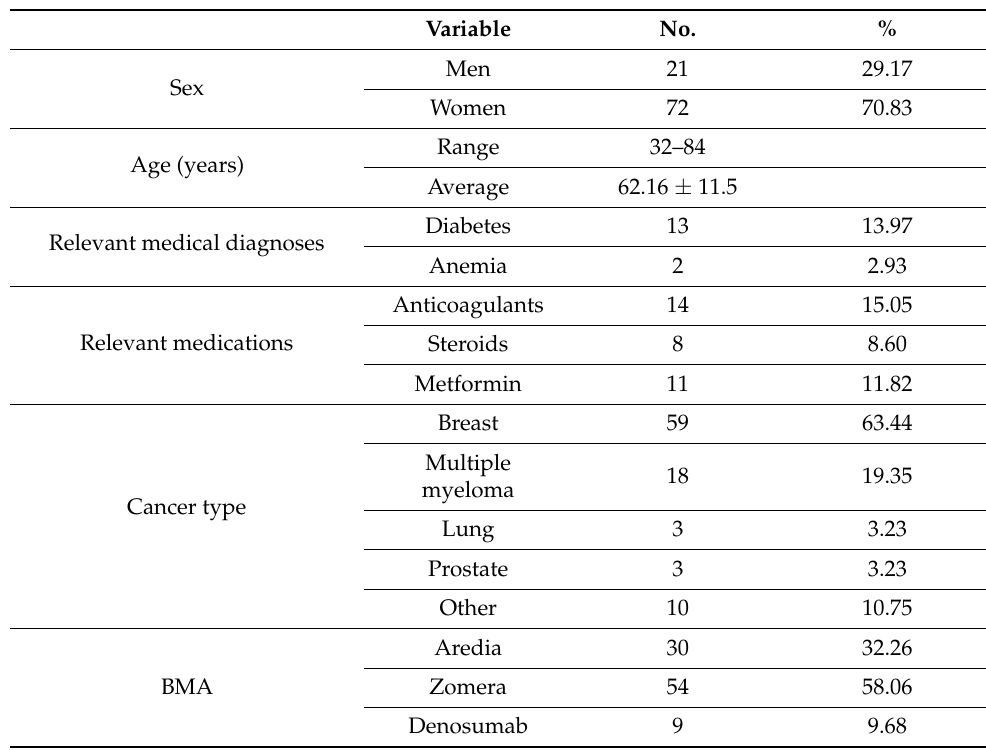
Table 1. Demographic data for the 93 patients in the study